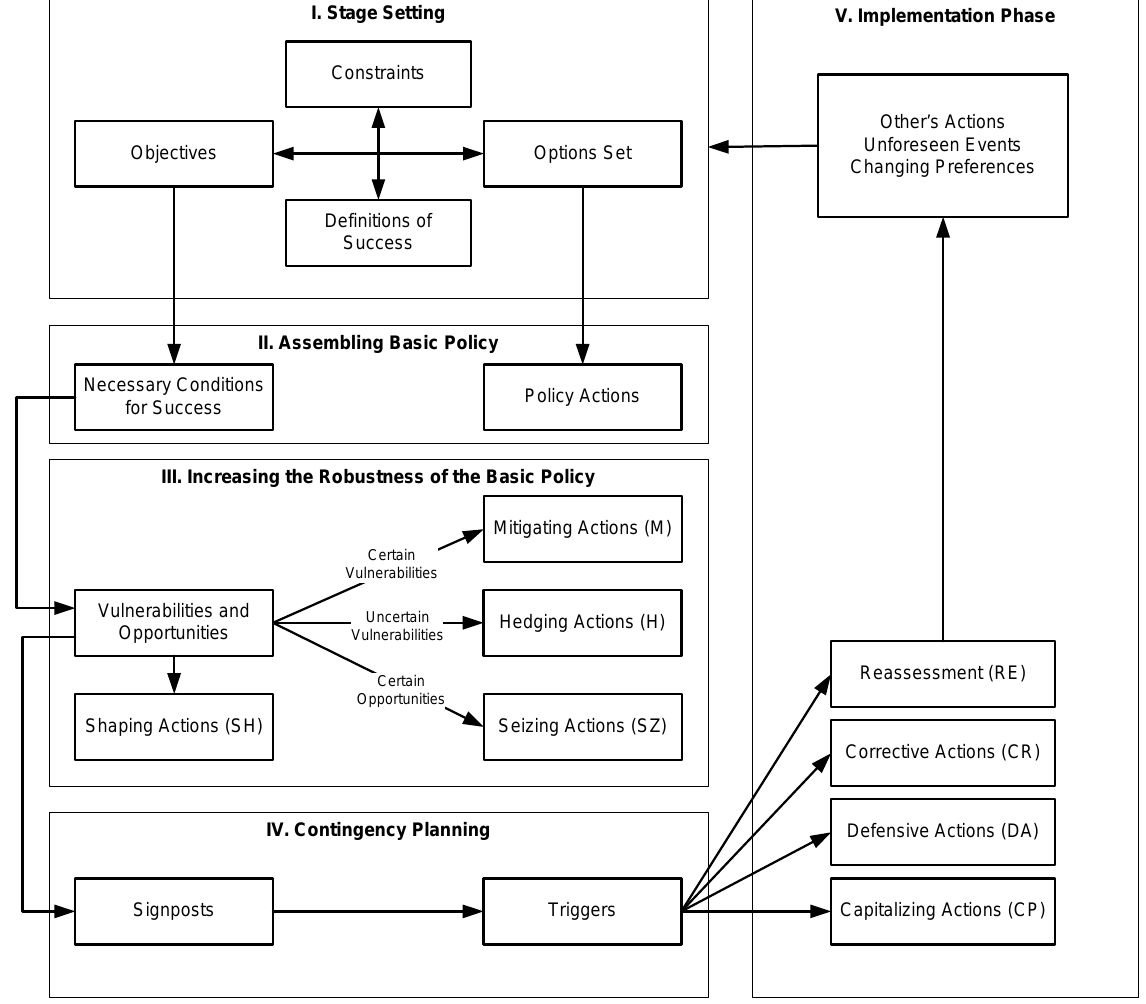
Figure 1. The Steps of Adaptive Airport Strategic Planning